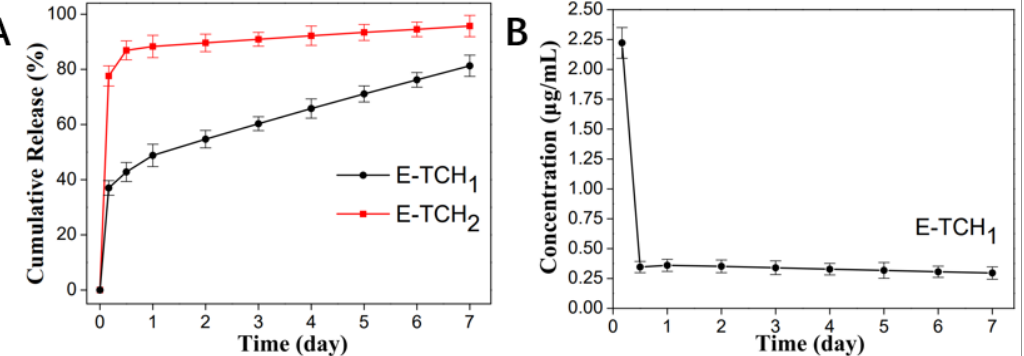
Figure 5. In vitro release behavior of TCH in different drug-loaded scaffolds. ( A ) In vitro drug release of E-TCH 1 and E-TCH 2 in a 7-day release period. ( B ) The residual TCH concentration at each time point.